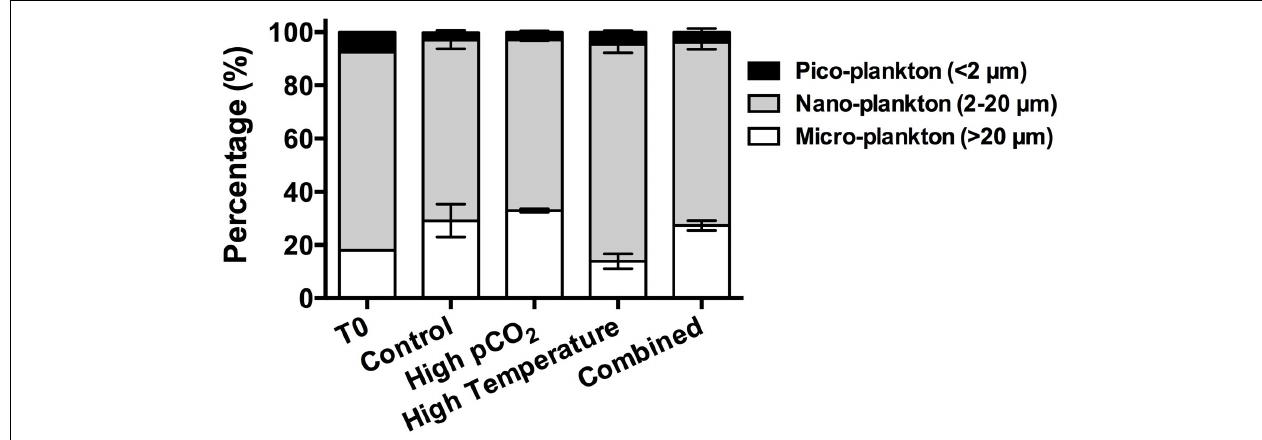
FIGURE 2 | Chl- a biomass percentages of micro-phytoplankton ( > 20 µ m), nanoplankton (2–20 µ m), and picoplankton (0.2–2 µ m) in the beginning of the incubation (T0) and in the four experimental treatments on the final sampling day. Values are the means and error bars are the standard deviations of triplicates.